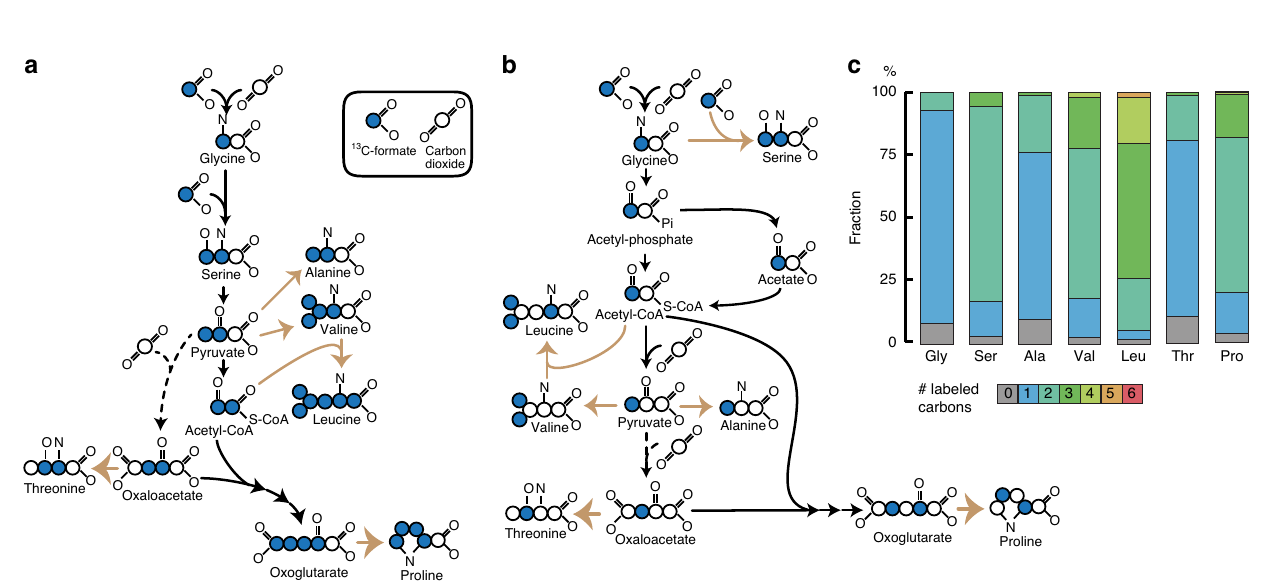
Fig. 4 Con fi rmation of the reductive glycine pathway via 13 C-labelled metabolomics. 13 C-labelled carbon signature expected in the serine route ( a ), glycine route ( b ) and obtained pattern of D . desulfuricans grown in autotrophic conditions ( c ) with addition of 13 C-formate. Autotrophic cultures (H 2 /CO 2 / sulphate) were supplemented with 75 mM sodium 13 C-formate (99% 13 C, Sigma-Aldrich) and grown in 30 mL bottles in 10 mL anoxic medium, cultivations were performed in biological triplicates. The dotted arrows indicate anaplerotic production of oxaloacetate via pyruvate carboxylase. Gly (glycine); Ser (serine); Ala (alanine); Val (valine); Leu (leucine); Thr (threonine); Pro (proline). Source data are provided with this paper, and data can be found in Supplementary Data